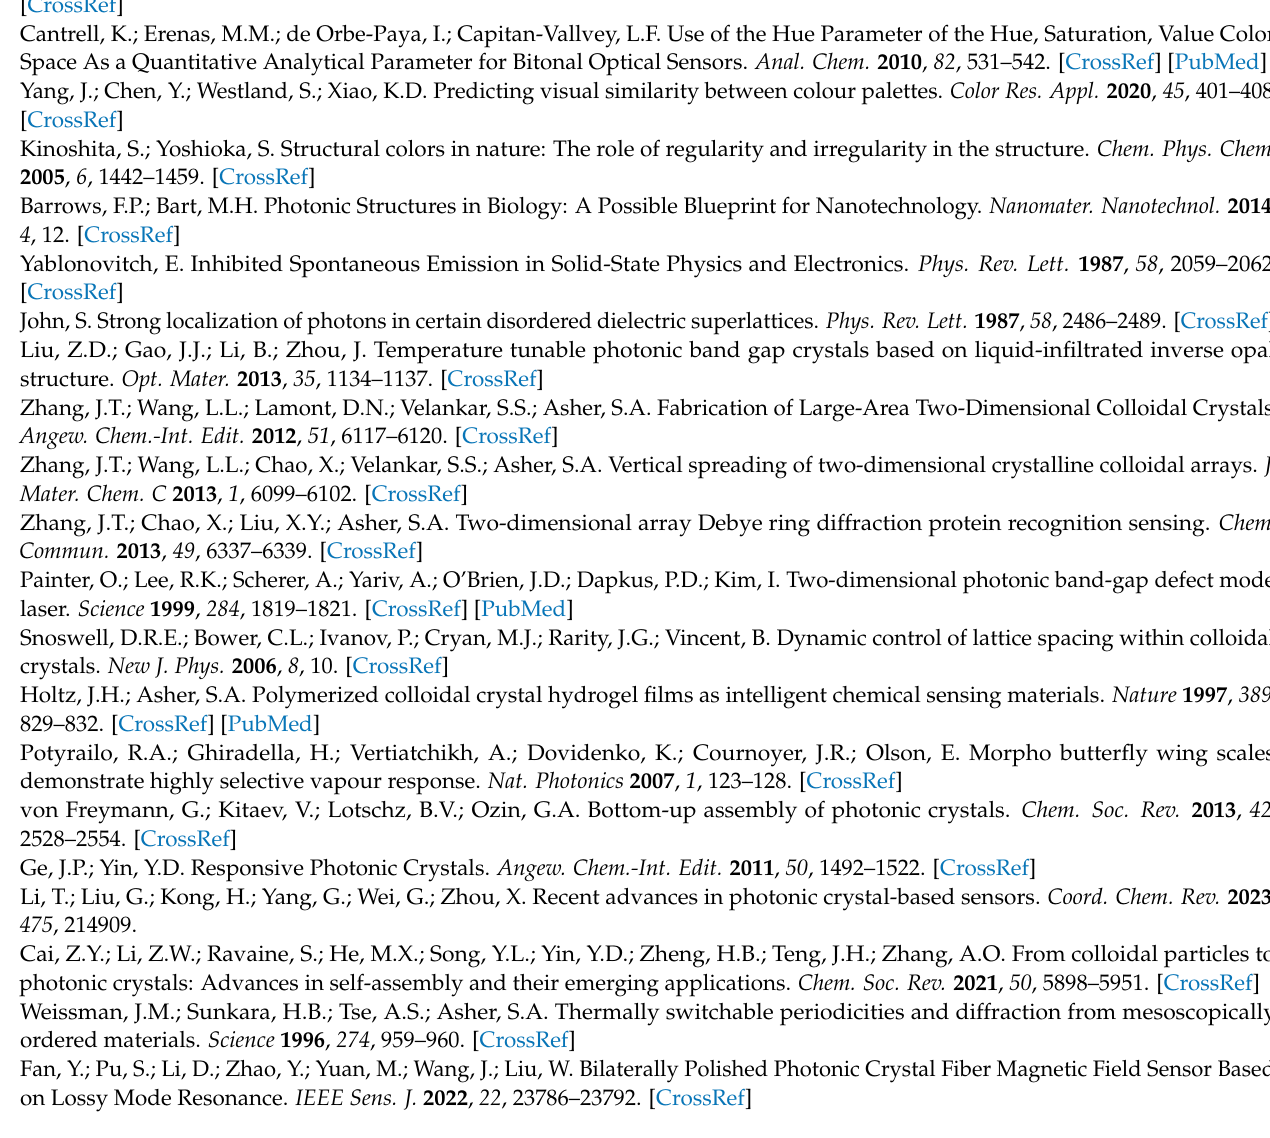
different; Figure S1: Color patches of 2D-PhCs; Figure S2: Color patches of 3D-PhCs; Figure S3: Color patches of temperature sensor; Figure S4: Color patches of humidity